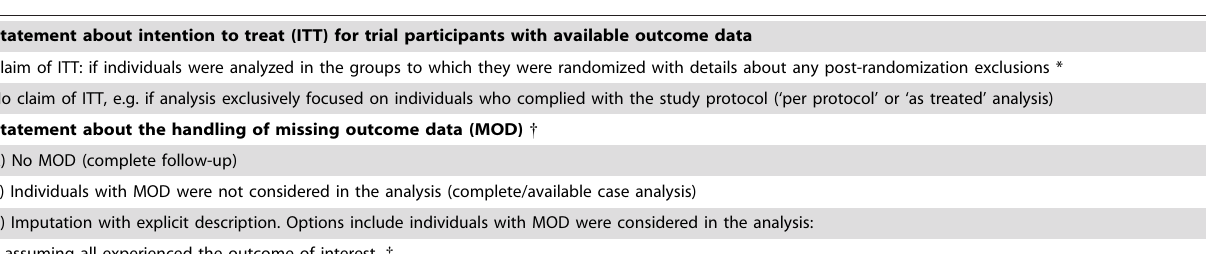
Statement about intention to treat (ITT) for trial participants with available outcome data Claim of ITT: if individuals were analyzed in the groups to which they were randomized with details about any post-randomization exclusions * No claim of ITT, e.g. if analysis exclusively focused on individuals who complied with the study protocol (‘per protocol’ or ‘as treated’ analysis) Statement about the handling of missing outcome data (MOD)